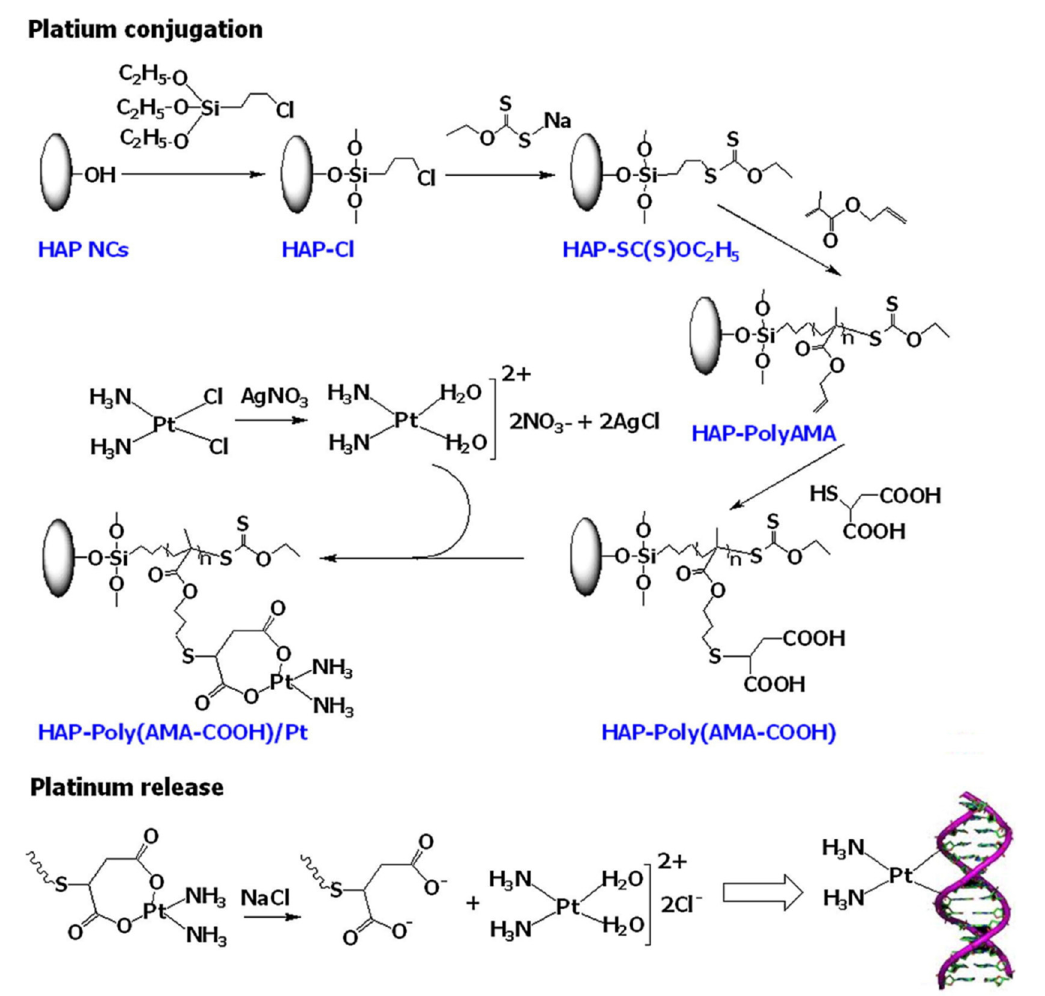
Figure 10. Synthetic route for HAP-PolyAMA nanohybrids via RAFT polymerization and cisplatin conjugation with a possible drug release mechanism as designed by Bach et al. Reprinted with permission from [76]; published by Elsevier, 2013.